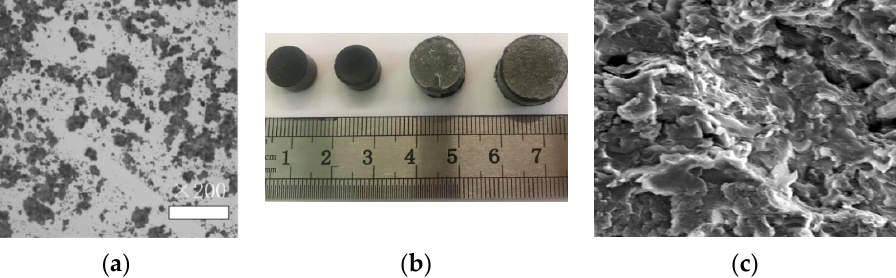
Figure 4. Scanning electron microscopy (SEM) analysis self-prepared graphene composite powder and bar. ( a ) Micro- structure; ( b ) Electrode bar; ( c )